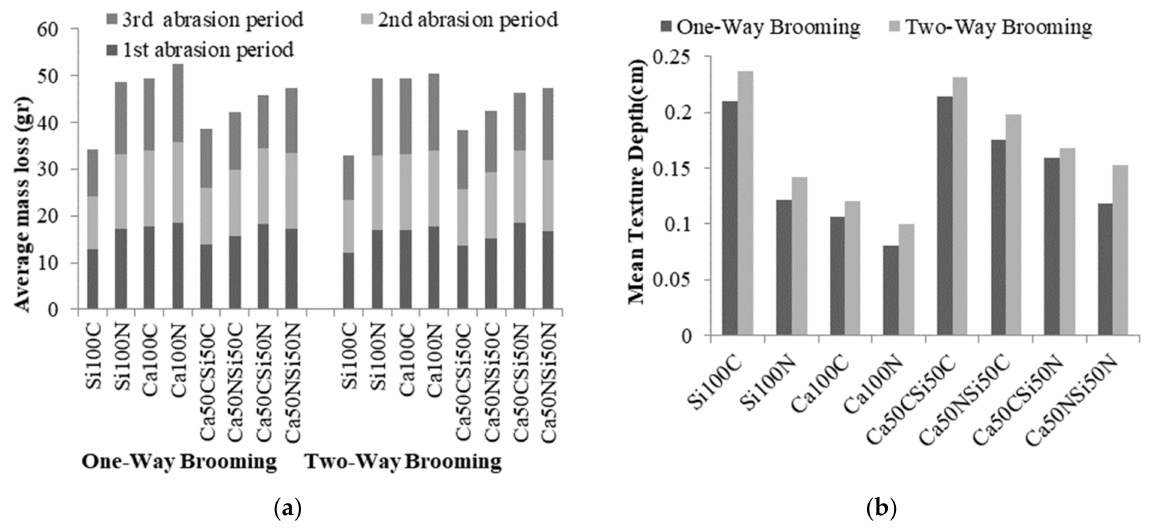
Figure 14. Abrasion resistance in form of average mass loss and MTD of brooming macro-textures versus different mix